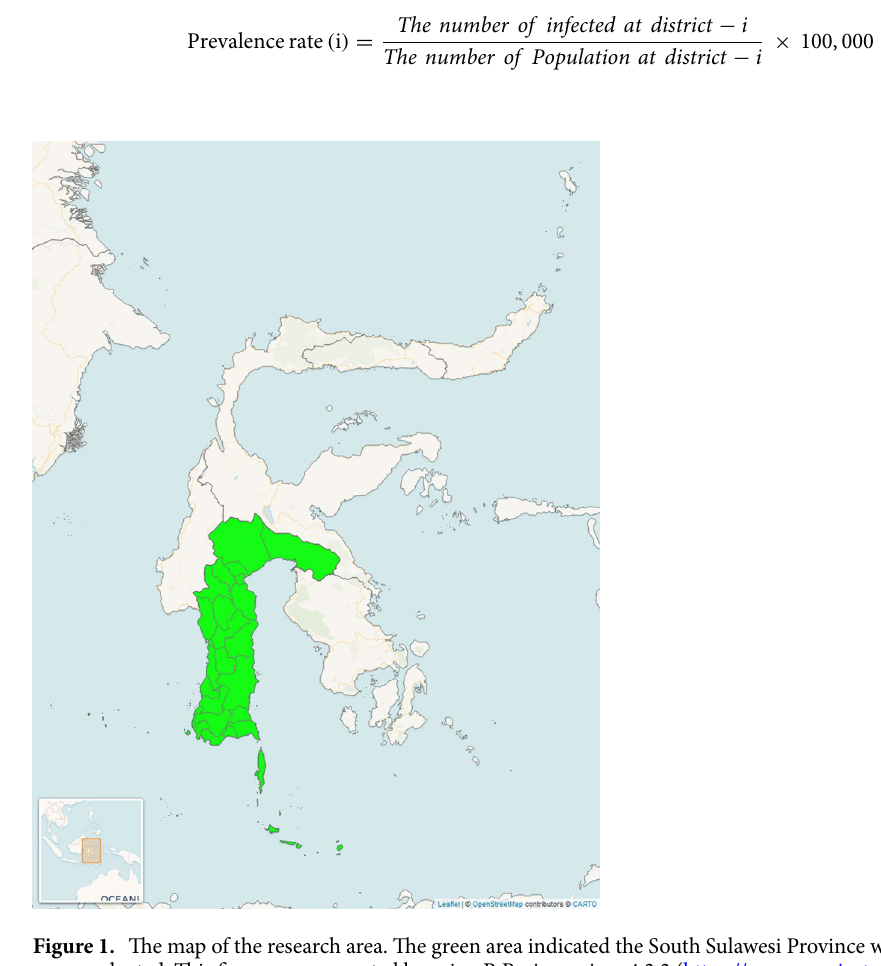
Figure 1. The map of the research area. The green area indicated the South Sulawesi Province where the study was conducted. This figure was generated by using R Basic version: 4.2.2 (https:// cran.r- proje ct. org/ bin/ windo ws/ base/) and R Studio Desktop version: 2022.07.2 + 576 (https:// posit. co/ downl oad/ rstud io- deskt op/) for windows operating system. We also utilized several packages to produce this figure such as sf package (https://r- spati al. github. io/ sf/), dplyr package (https:// github. com/ tidyv erse/ dplyr), rgdal package (http:// rgdal.r- forge.r- proje ct. org/), tmap package (https:// github. com/r- tmap/ tmap) and leaflet package (https:// rstud io. github. io/ leafl